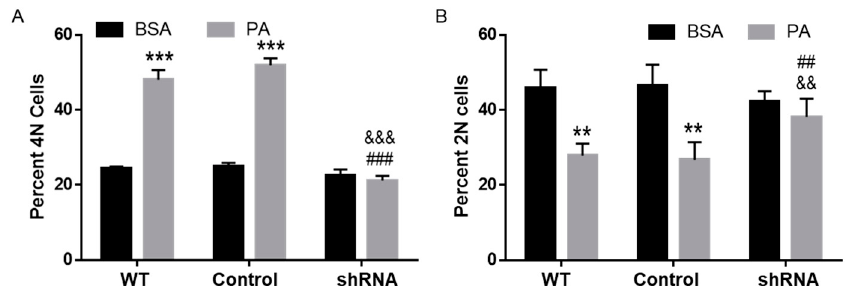
Figure 7. Cell cycle analysis of N2a cells stably transfected with CD36 shRNA. N2a cells stably transfected with CD36 shRNA or non-mammalian shRNA were treated with BSA or 200 µ M PA for 6 h with WT cells as naïve control. Their cell cycle profiles were then analyzed by flow cytometry with quantitated 4N data shown in ( A ) and quantitated 2N data shown in ( B ). Data presented (Mean ± SEM) were representative of three independent experiments. Data were analyzed using two-way ANOVA followed by Tukey’s multiple comparison test. ** p < 0.01 vs. corresponding BSA-treated cells; *** p < 0.001 vs. corresponding BSA-treated cells; ## p < 0.01 vs. 200 µ M PA-treated control cells; ### p < 0.001 vs. 200 µ M PA-treated WT cells; && p < 0.01 vs. 200 µ M PA-treated control-transfected cells; &&& p < 0.001 vs. 200 µ M PA-treated control-transfected